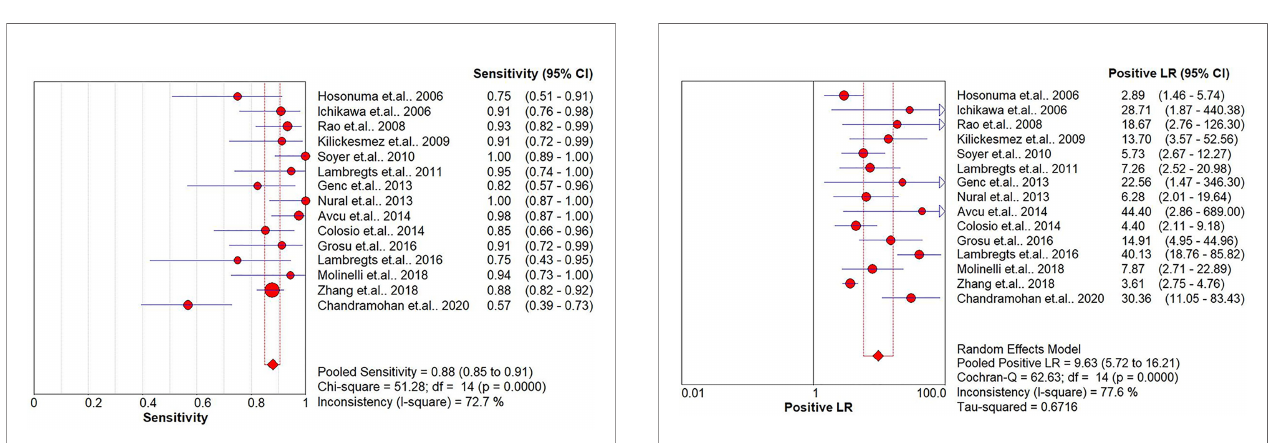
FIGURE 2 | Summary of the sensitivity analysis of the included studies.